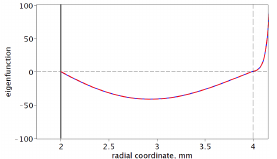
Figure 2. Nonlinearity coefficient α = 2 × 10 − 5 mm/V. Marked eigenvalues: linear eigenvalue β ≈ 5 . 0815 (blue dot); nonlinear eigenvalue β ≈ 5 . 0893 (red dot).